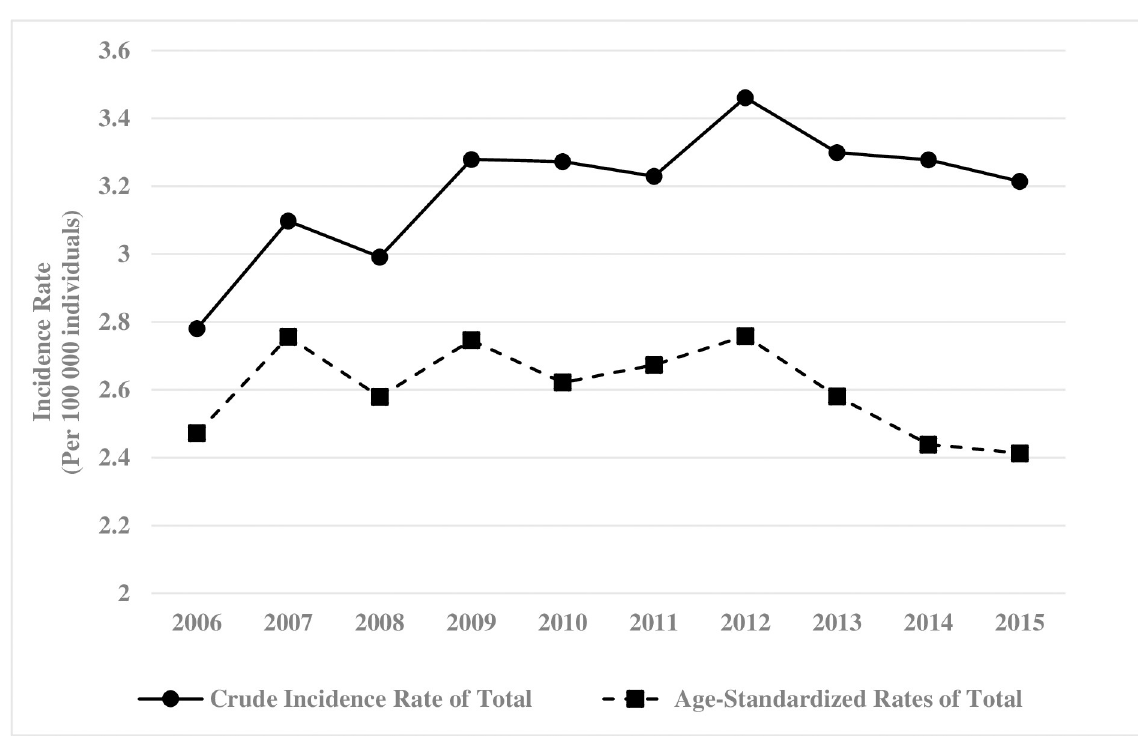
Fig 2. 2006 to 2015 annual incidence and age-standardized rate of acute myeloid